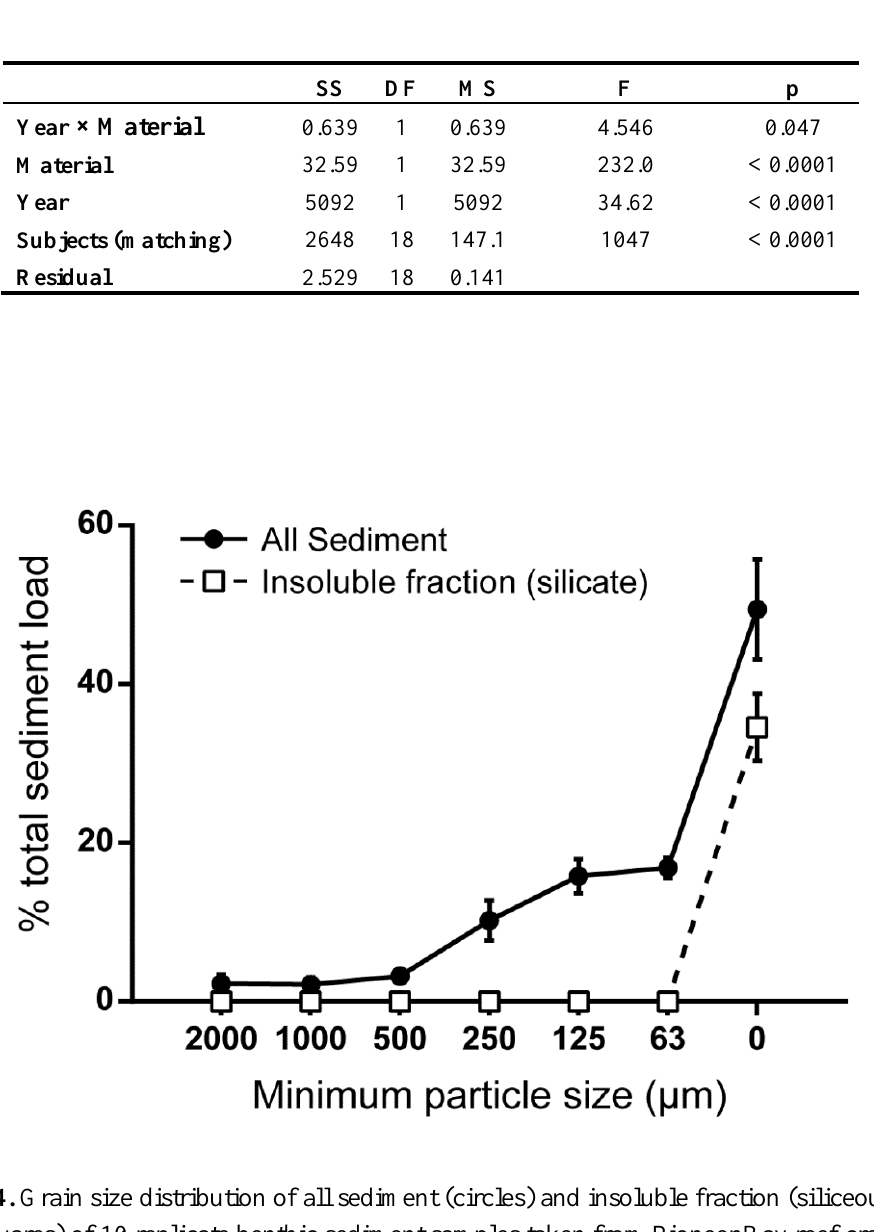
Figure A1.4. Grain size distribution of all sediment (circles) and insoluble fraction (siliceous material; squares) of 10 replicate benthic sediment samples taken from Pioneer Bay reef crest. On average 34.6 ± 4.2 % (mean ± standard error) of each sediment sample was siliceous material, all of which was in the <63 µm grain size category. On average 70.9 ± 2.2 % of all sediment in this grain size class was siliceous